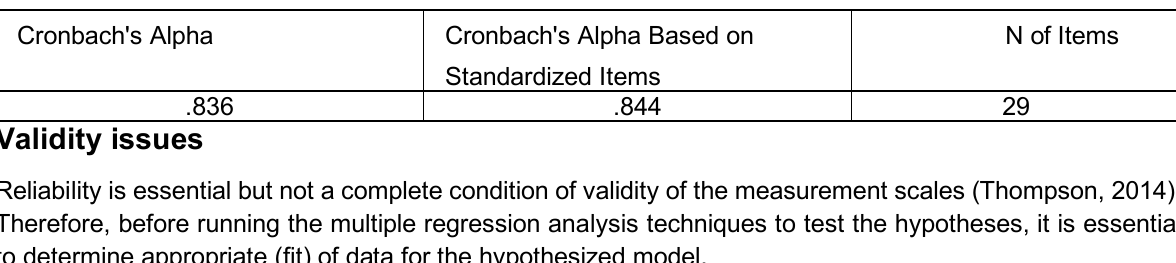
Table 5: Reliability